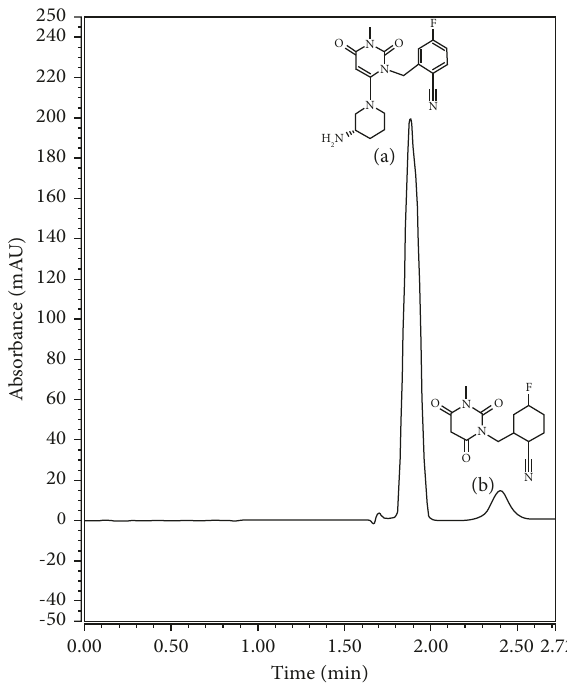
Figure 1: HPLC-UV chromatogram of laboratory-prepared mixture containing concentrations equivalent to 45 µ g/mL and 9 µ g/mL of TRG (a) and TAD (b),